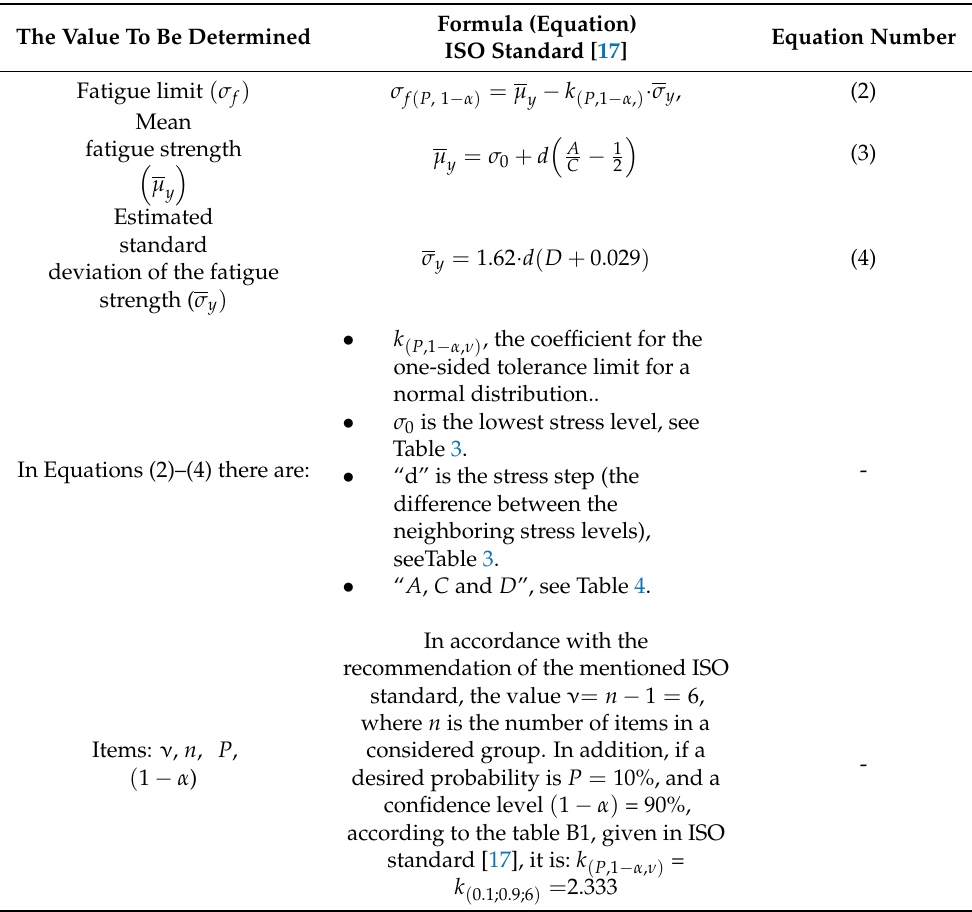
Table 5. Fatigue limit calculation procedure.